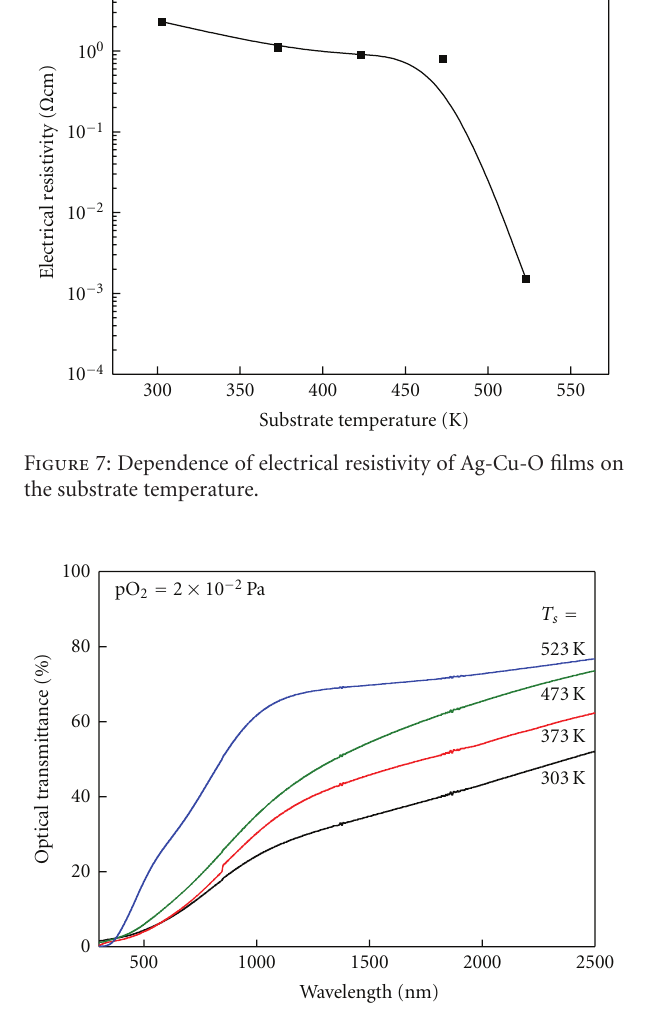
Figure 8: Optical transmittance spectra of Ag-Cu-O films formed at di ff erent substrate temperatures.